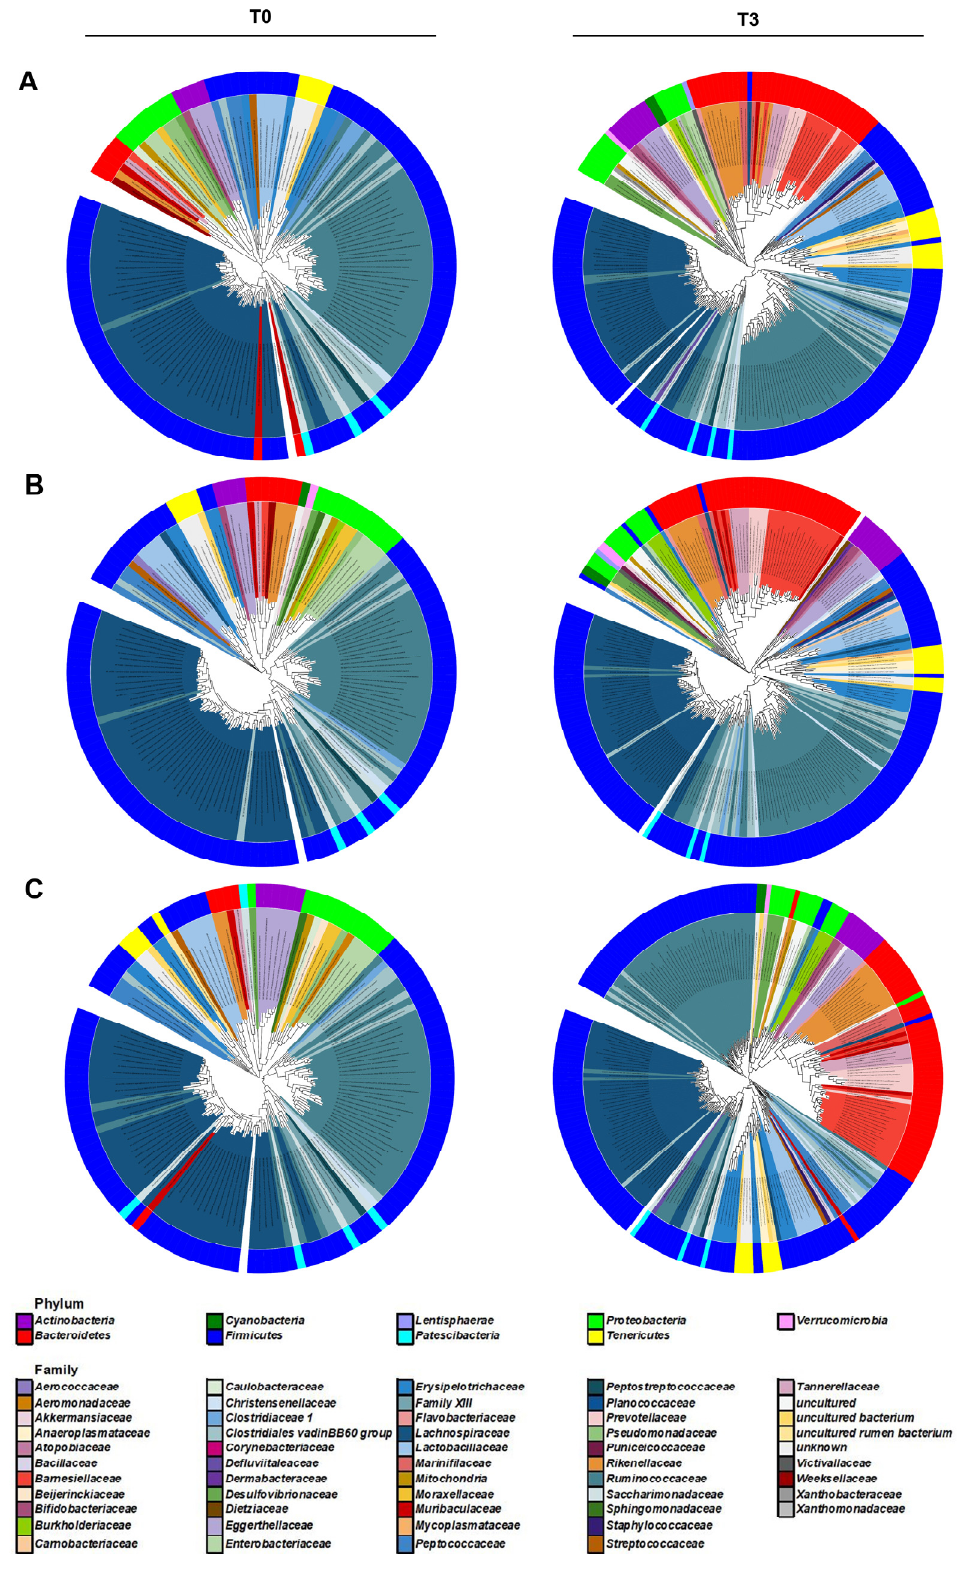
Figure 6. The maximum-likelihood phylogenetic tree consisting of the gut microbiome taxa in the PBW, MBW, and NBW groups. The outer rings of the circular dendrogram represent the phylum level, and the inner layers represent the family level. ( A – C ) are PBW, MBW, and NBW groups each before (T0, ( left )) and after (T3, ( right )) the replacement.